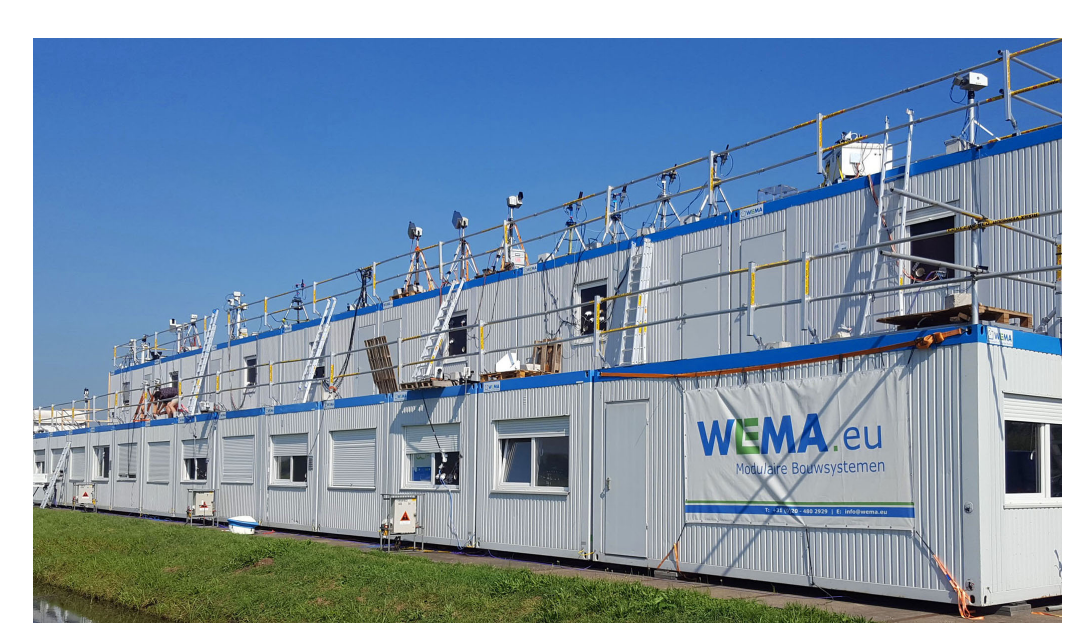
Figure 1. Picture of the CINDI-2 container layout at the main campaign site showing the organisation of the MAX-DOAS instruments on two superposed rows of mobile units (similar to shipping